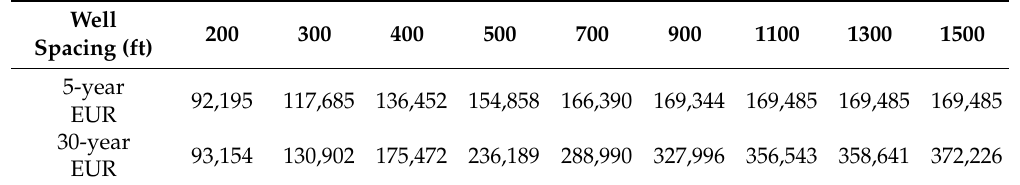
Figure 15. ( a ) Flow-cell model forecasts for 5-year and 30-year EUR (Mscf), due to well-spacing changes between 200 and 1500 ft. ( b ) Mismatch ∆ (see Equation (12)) of the flow-cell based 5-year and 30-year EURs (Table 7) and those produced with the ResFrac simulator (Table 3). Table 7. Variation of 5-year and 30-year EURs (Mscf) when producing with well spacing varying between 200 and 1500 ft, as forecasted by the flow-cell